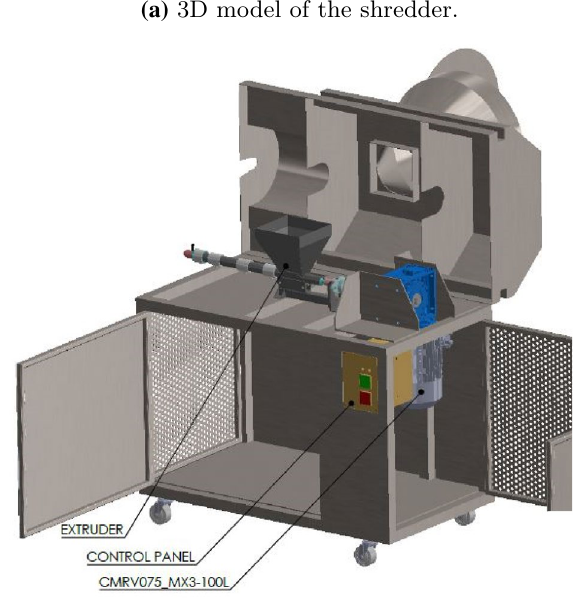
(a) 3D model of the shredder.